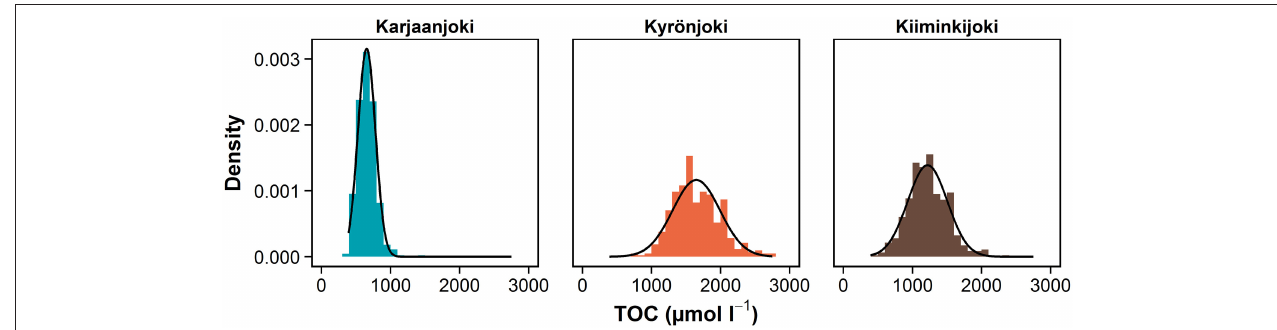
FIGURE 8 | Density of observed TOC concentrations in river end-members of study estuaries between 1975 and 2014. Mean values, standard deviation and range: Karjaanjoki ( n = 442 ) 655 (126, 392–1417), Kyrönjoki ( n = 425 ) 1648(342, 758–2750), and Kiiminkijoki ( n = 463 ) 1217(287, 467–2333) µ mol L − 1 . More than 90% of TOC is in dissolved form (DOC) in these systems (Mattsson et al., 2005). Data source: Räike et al. (2012). Normal distribution curve is fitted over each density histogram.